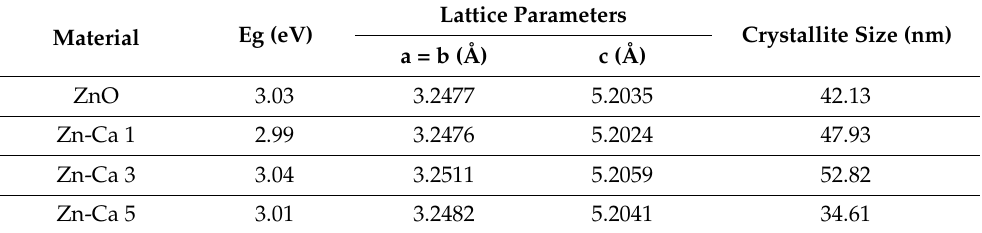
Figure 1. Scanning electron microscopy images of Zn-Ca nanocomposites. ( a ) ZnO, ( b ) Zn-Ca 1, ( c ) Zn-Ca 3, ( d ) Zn-Ca 5. Table 1. Surface analysis of